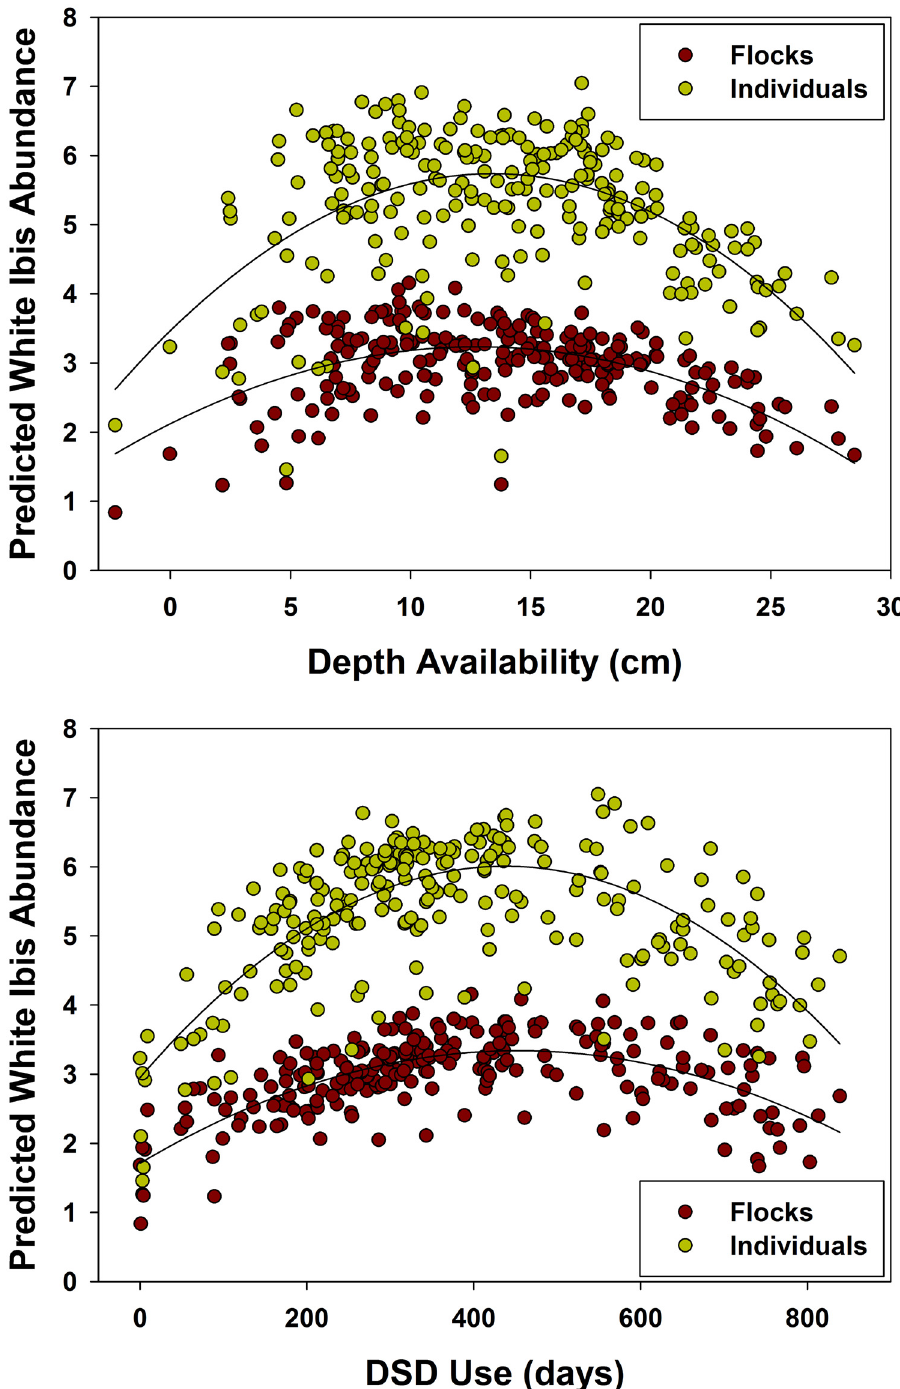
Fig 3. Daily mean landscape flocks and individuals (fourth-root transformed) predicted by the model- averaged terms for the White Ibis. Predicted presence and abundance are highest with an average landscape depth (within available depths) of 10 – 17 cm and when White Ibis are using an average DSD of ~450 days.